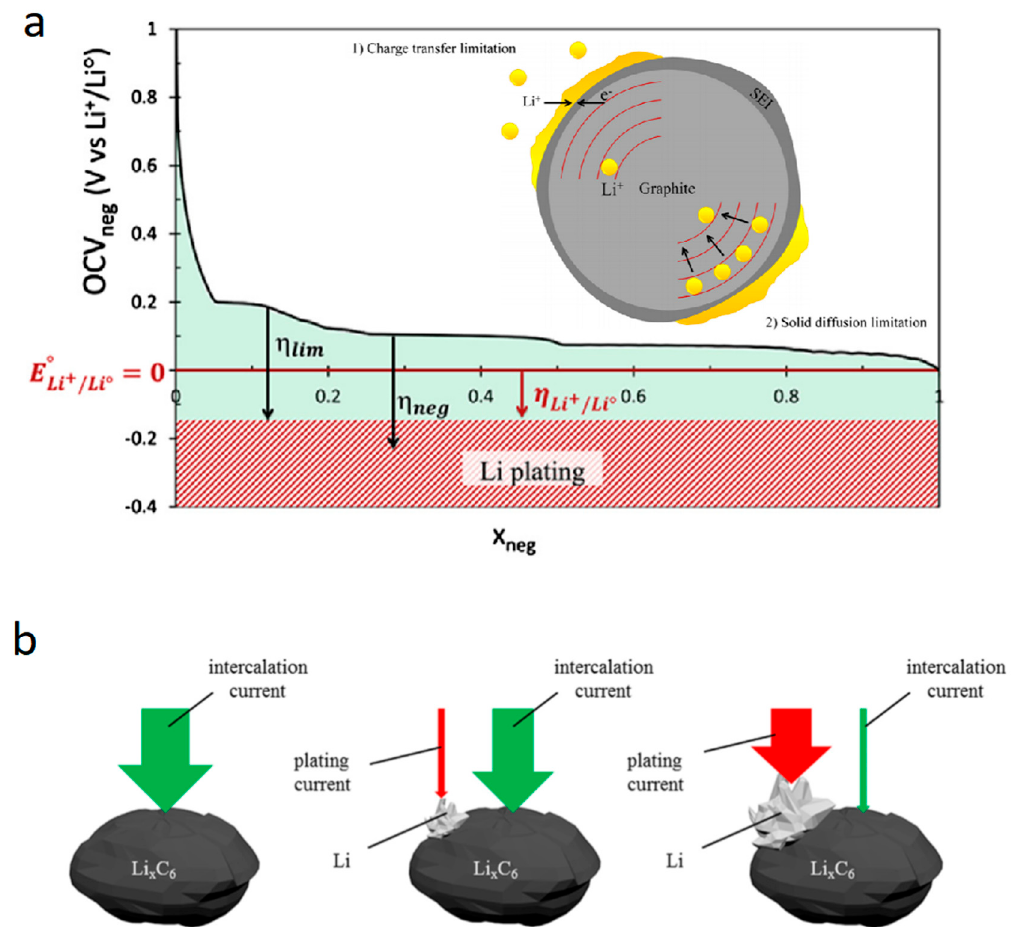
Figure 7. Schematic representation of Li plating occurrence ( a ); schematic illustration of Li plating occurring at the surface of the negative active particle (an insert) [60]; schematic illustration of the separation of the charging current into plating and intercalation currents during different states of charging. Depending on Li surface concentration and applied current, the charging current splits into different contributions from plating and intercalation ( b ) [61]. Reproduced by permission of Elsevier.